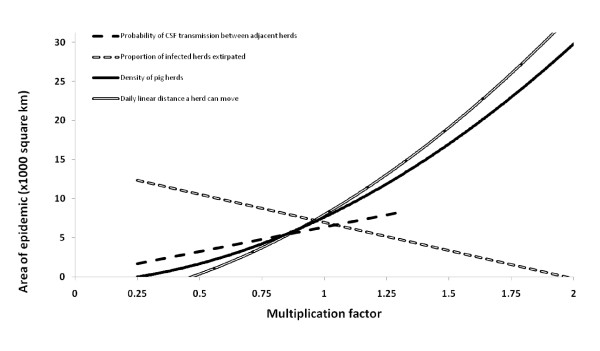
Parameters with a large influence on Classical Swine Fever outbreaks in wild pigs identified during one at a time sensitivity analyses. The figure shows the effect of changing each influential parameter on outbreak size. The correlation between outbreak size and the level of parameter was greater than 0.9 for all parameters (data points not shown). Multiplication factor of 1 was the best estimate/baseline.